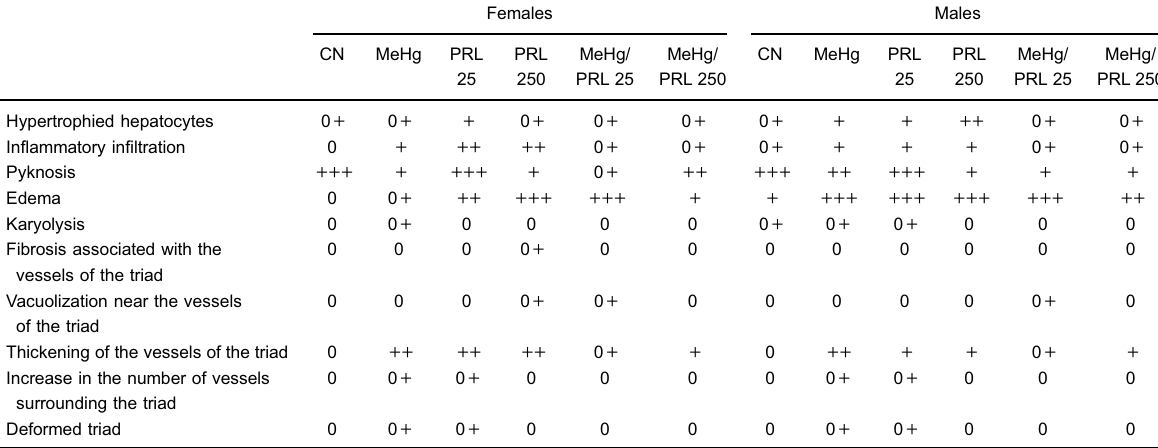
Table 1. Alterations observed in the liver tissue of the mice of each treatment group.